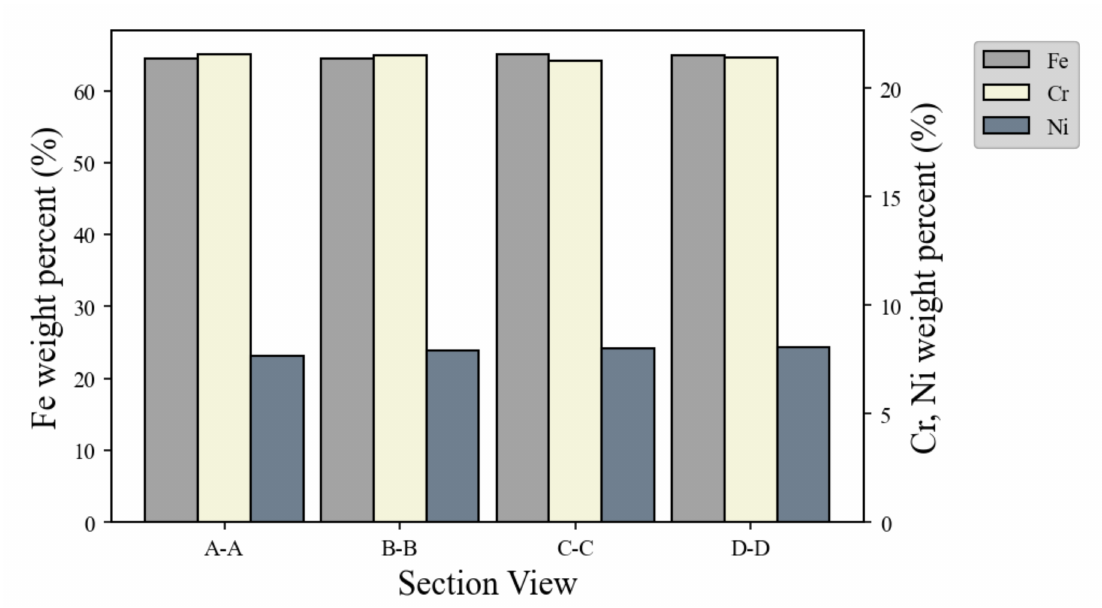
Figure 14. Schematic of measurement at the intersection